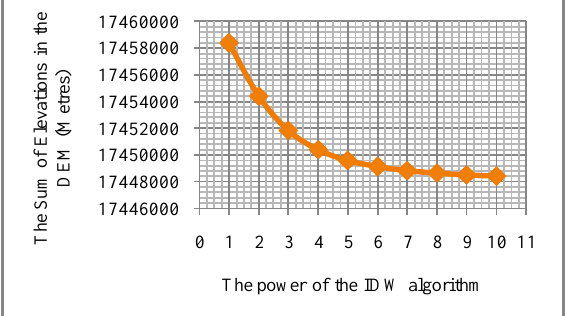
Figure 22: The effect of changing the power of the IDW on the sum of the elevations in the generated DEM.